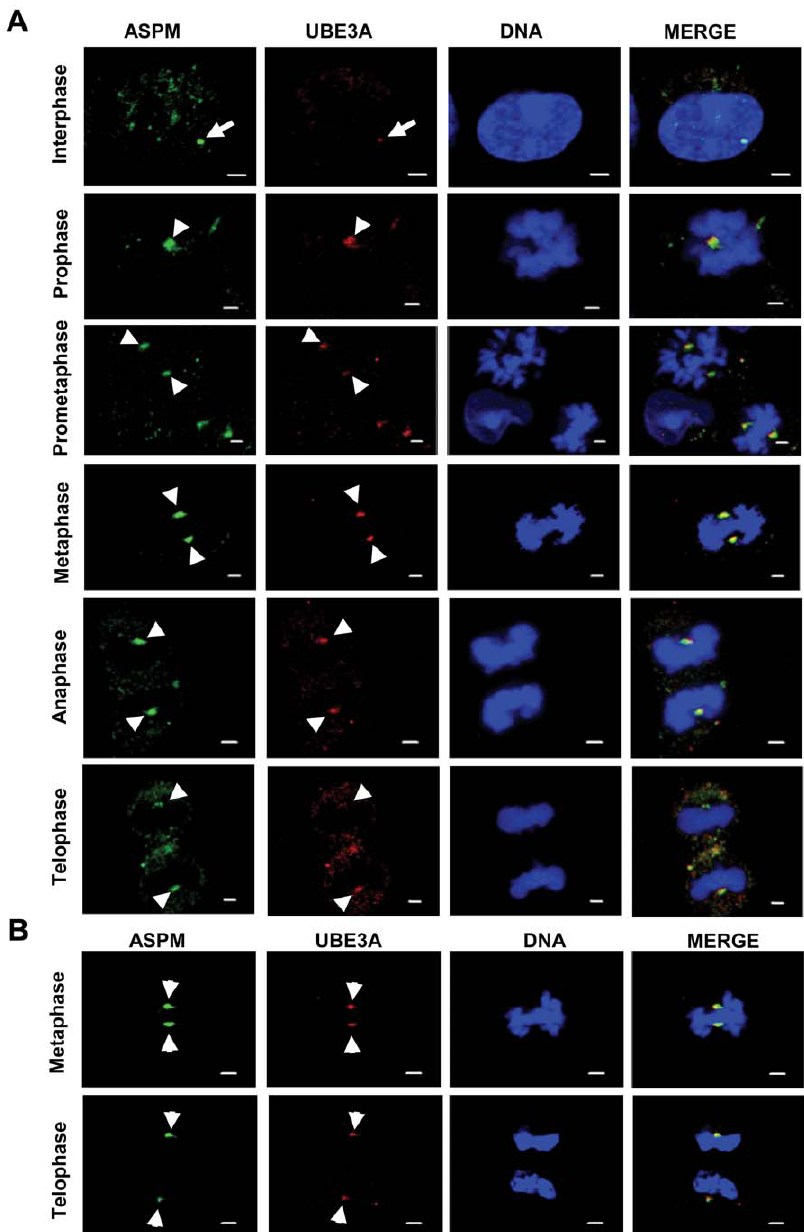
Figure 3. UBE3A colocalizes with ASPM at the centrosome. (A) Indirect immunofluorescence of HEK293 cells at interphase and different phases of mitosis stained with antibodies against ASPM and UBE3A (anti-UBE3A-sc-8926). Note colocalization of UBE3A with ASPM at the centrosome throughout mitosis (arrowheads). Note weak centrosomal staining of UBE3A in an interphase cell (arrow). (B) Indirect immunofluorescence of A549 cells stained with antibodies against UBE3A (anti-UBE3A-sc-8926) and ASPM at metaphase and telophase. Note colocalization of UBE3A with ASPM at the centrosome (arrowheads). Scale bar=2 m m.